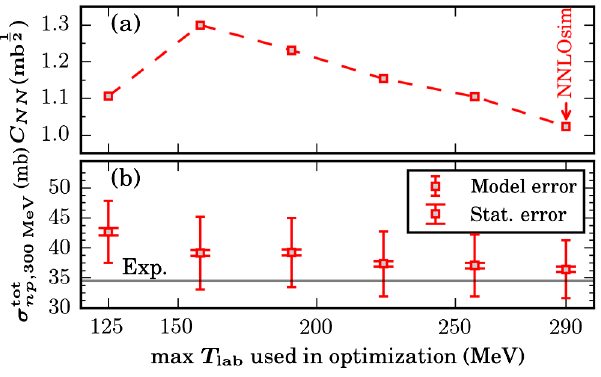
FIG. 10. Predictions for the different reoptimizations of NNLO- sim. On the x axis is the maximum T for the NN scattering lab data used in the optimization. (a) Model error amplitude (20) 1 for the respective data subset. reoptimized so that χ 2 =N dof ¼ (b) Model prediction for the np total cross section at T lab ¼ 300 MeV with error bars representing statistical and model errors for the different